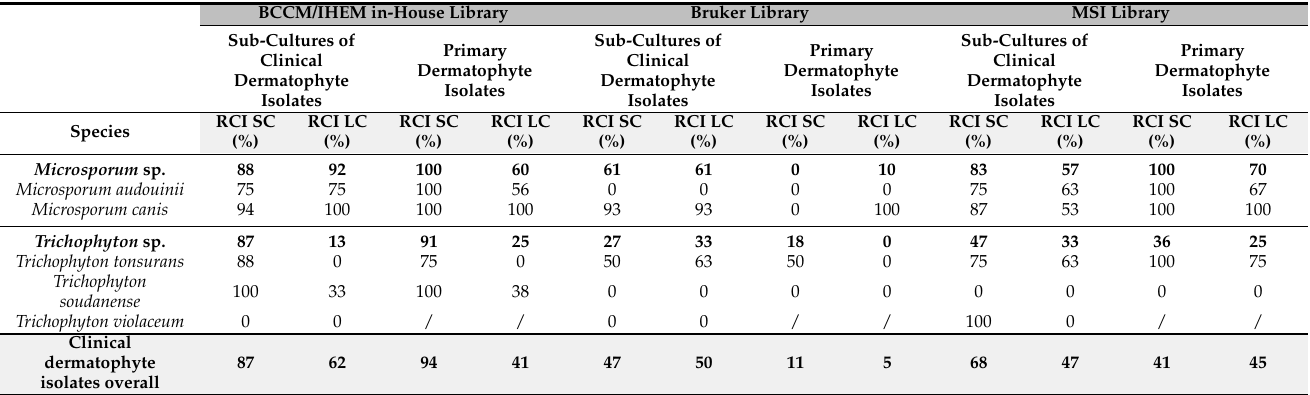
Table 3. Rate of correct identification (RCI) per species, per genus, and overall, using the MALDI-TOF MS protocol based on solid (SC) or liquid cultures